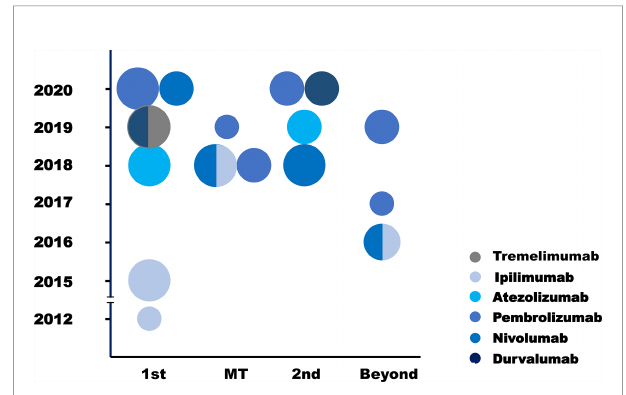
FIGURE 1 | Clinical trials of ICIs in SCLC. Each circle standed for one trial. The different circle areas represented phase I, phase II and phase III trials respectively, and different color meant different drugs. Y axis stood for the year of the publication of each trial, and X trials was the clinical situation where each trial was performed. 1st, fi rst line; MT, maintenance therapy; 2nd, second line; Beyond, later